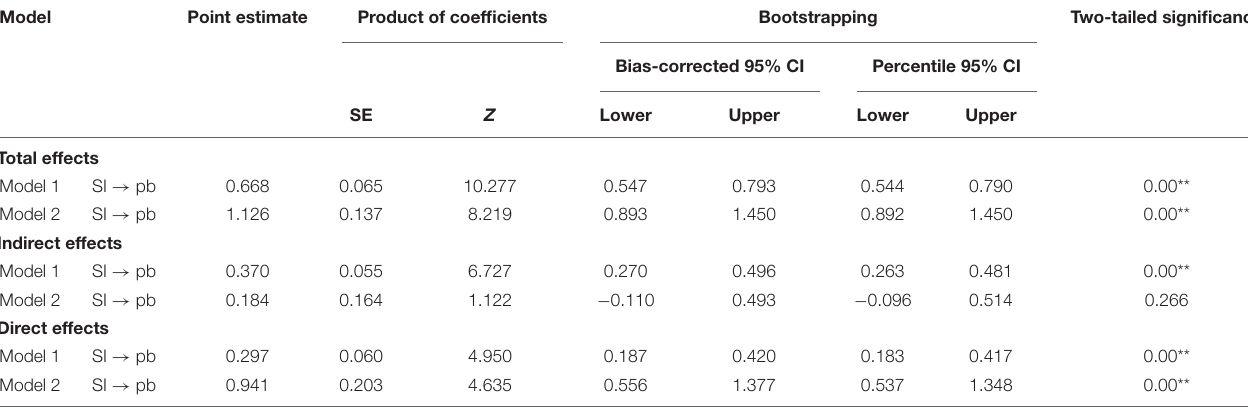
TABLE 7 | Unstandardized direct, indirect, and total effects of the female and male model.